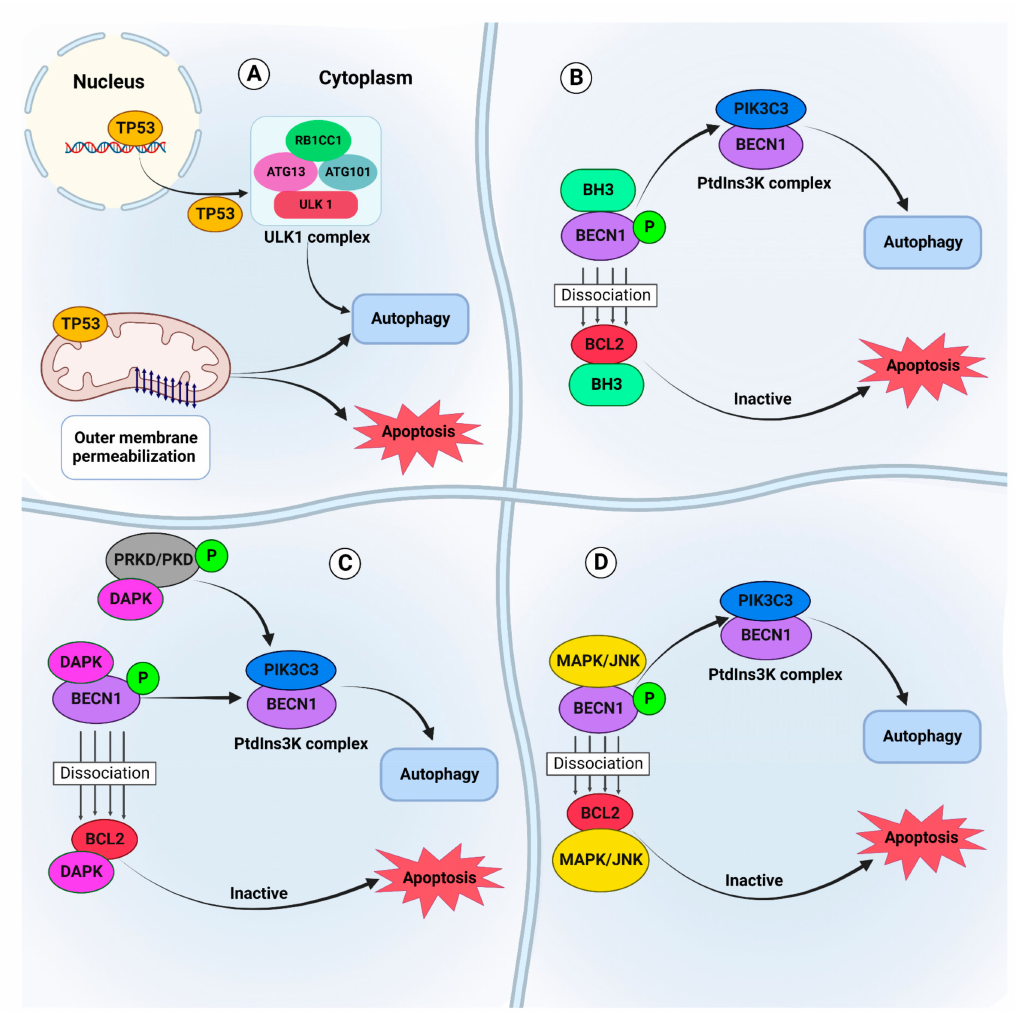
Figure 3. The crosstalk between signals that induce both apoptosis and autophagy. ( A ) The tumor suppressor TP53 has both pro-apoptotic and pro-autophagic functions depending on its subcellular localization. ( B ) BH3 (BCL2 homology domain 3) proteins interact with BECN1 and BCL2 to activate autophagy and apoptosis. ( C ) DAPK (death associated protein kinase) can stimulate autophagy and apoptosis by phosphorylating BECN1, driving its dissociation from BCL2. DAPK can also activate PRKD/PKD, which phosphorylates and activates PIK3C3/VPS34. ( D ) MAPK/JNK induces autophagy and apoptosis by phosphorylating and inactivating BCL2 and activating the BECN1- PIK3C3/VPS34 complex. The figure was created with BioRender.com. Licensing Right DV24OB65T6, 21 November